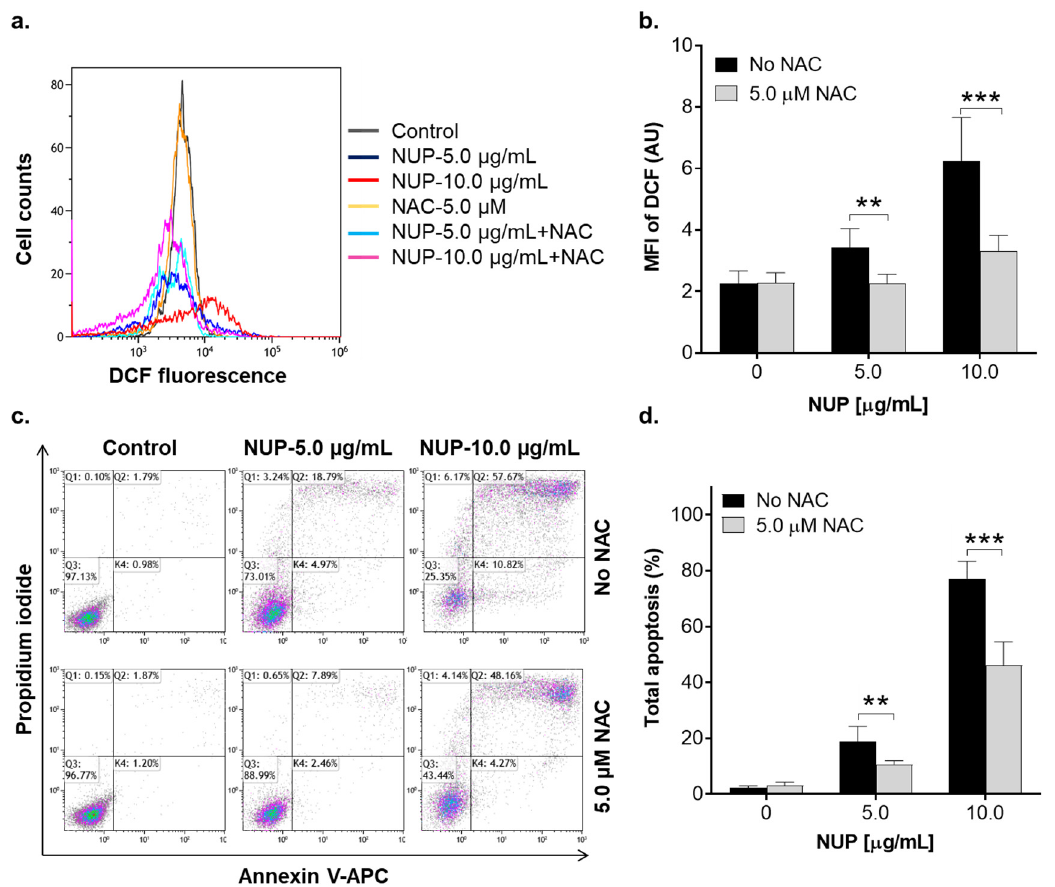
Figure 6. The thiol antioxidant N-acetylcysteine abrogates ROS accumulation and partially inhibits apoptosis induction in NUP-treated cells. HL60 cells were pre-incubated with 5 µM NAC for 1 h followed by the addition of 5 µg/mL or 10 µg/mL NUP for another 24 h. Cytosolic ROS levels and the extent of apoptosis were then measured, as described above. ( a ) Typical examples of cytosolic ROS measurement from a representative experiment. ( b ) Averaged ROS levels expressed as DCF geometric mean fluorescence intensity (MFI) units. ( c ) Typical annexin-V/PI binding data obtained in a representative experiment. ( d ) Averaged percentages of apoptotic (early + late) cells. The data are means ± SD of 3 independent experiments performed in duplicate. **, p < 0.01 and ***, p < 0.001, significant differences between the indicated groups.